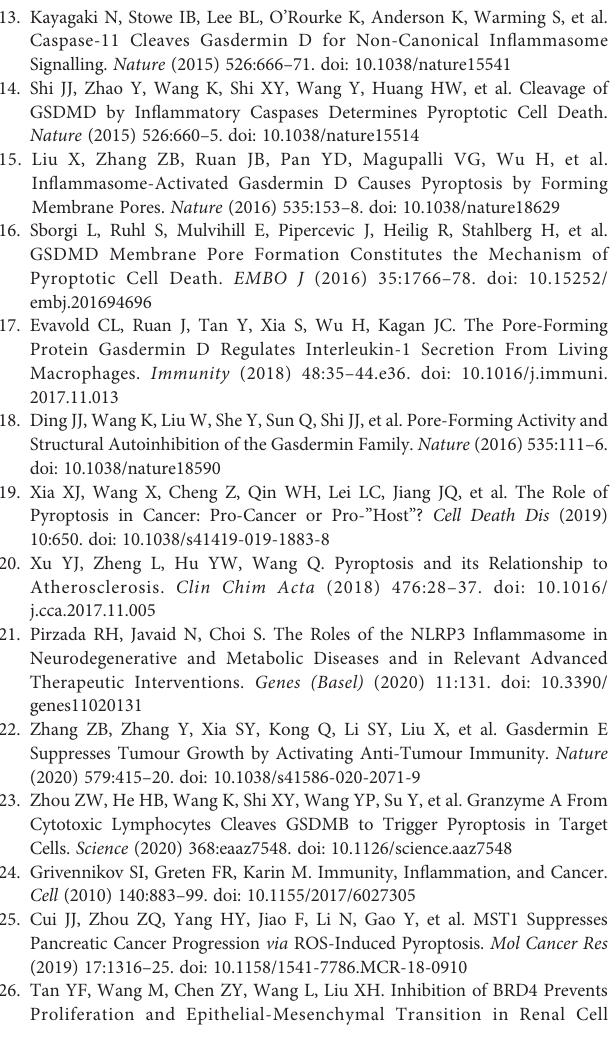
Supplementary Figure 1 | Nineteen pyroptosis-related genes classify glioma patients into different clinicopathological features and OS in the CGGA dataset. (A) Cumulative distribution function of consensus clustering for k = 2 to 9. (B) The